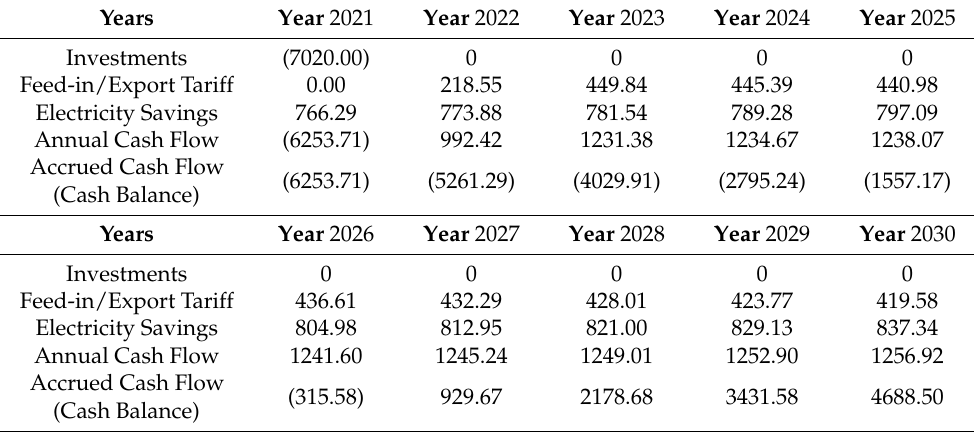
Table 8. Cash flow (USD) analysis of the campus microgrid.